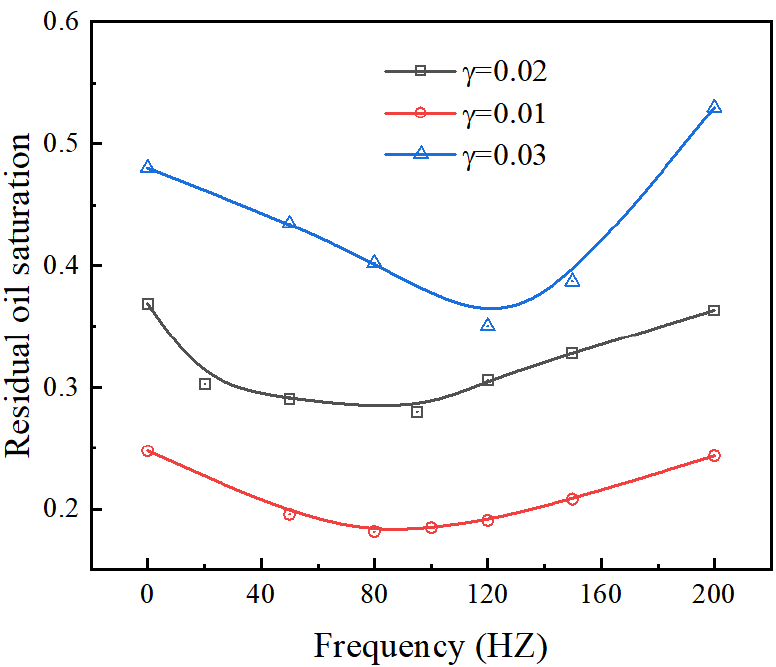
Figure 5. Comparison of residual oil saturation affected by various interfacial tensions γ in different frequencies.